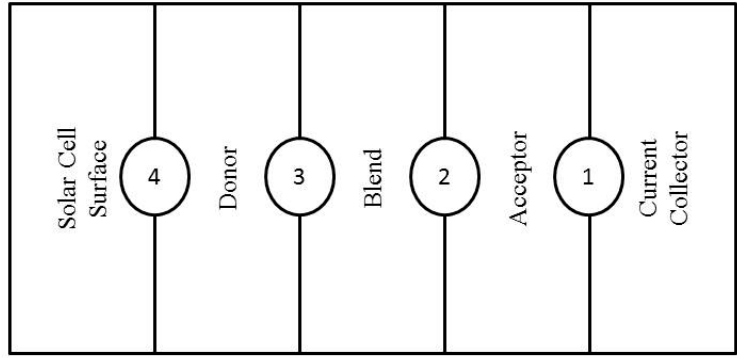
Figure 10. Representation of the solar cell active layers, for imposing boundary conditions.